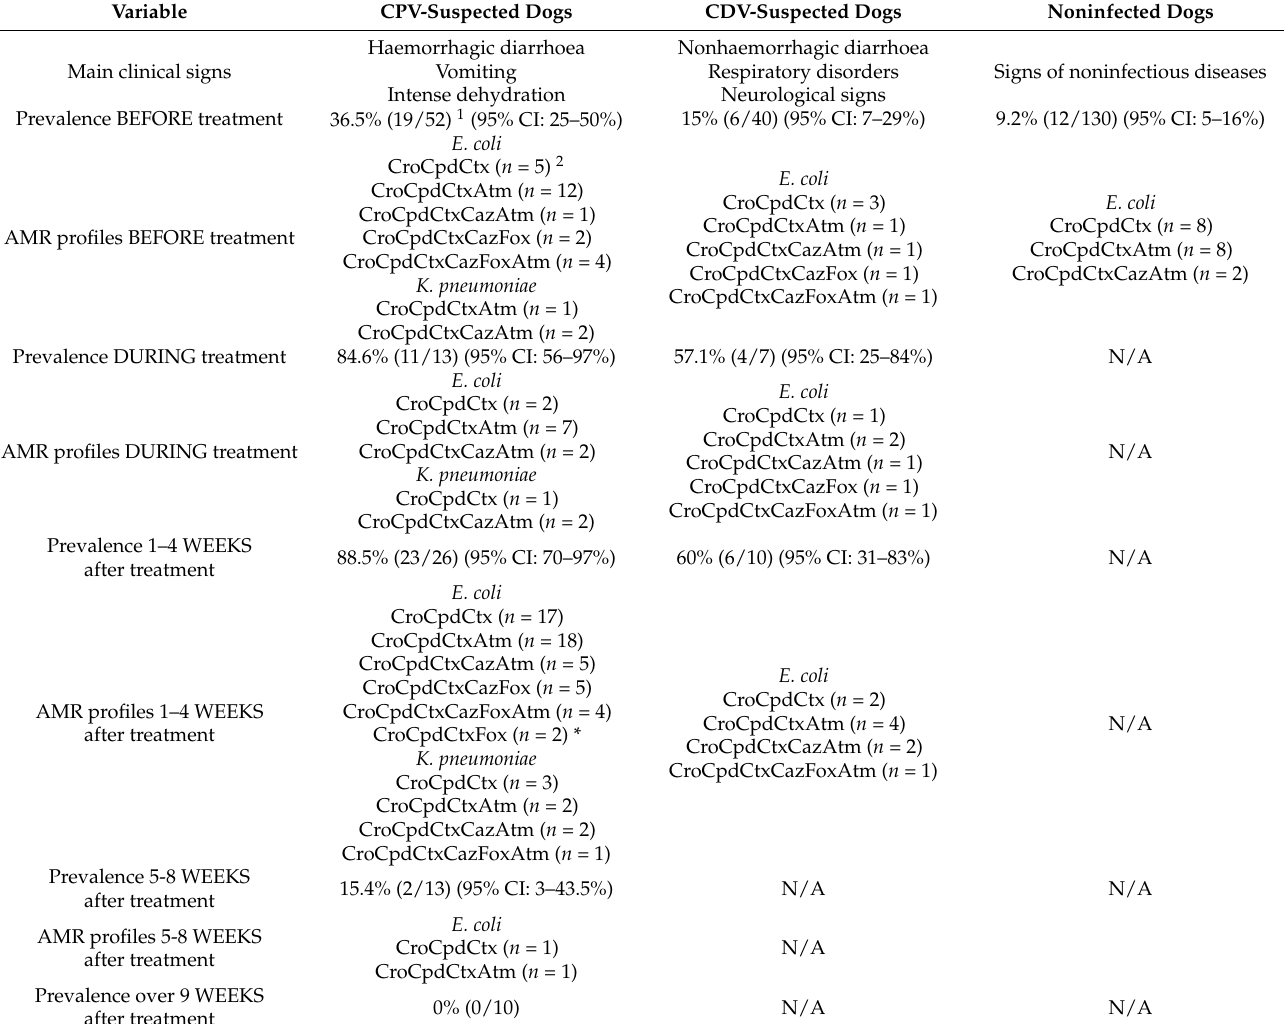
Table 1. Clinical signs, prevalence of extended-spectrum cephalosporin-resistant Enterobacterales (ESCR- E ) and antimicrobial resistance profiles isolated from faeces of dogs clinically diagnosed with canine parvovirus (CPV) and canine distemper (CDV) infections before and after prophylactic antibiotic therapy with third-generation cephalosporin and from dogs with noninfectious